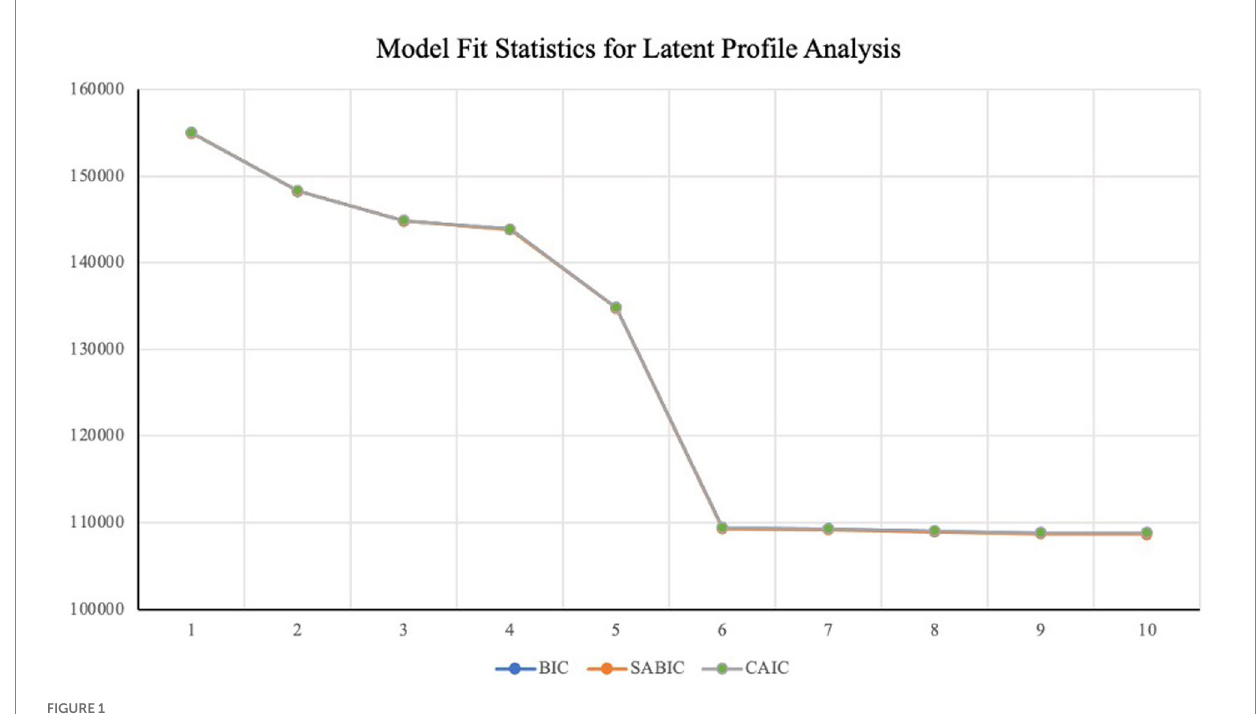
FIGURE 1 Model fit statistics for latent profile